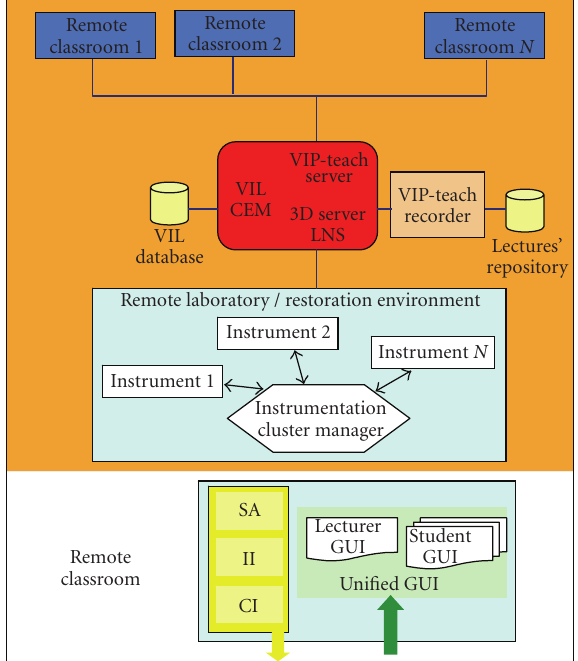
Figure 3: Main blocks of the software